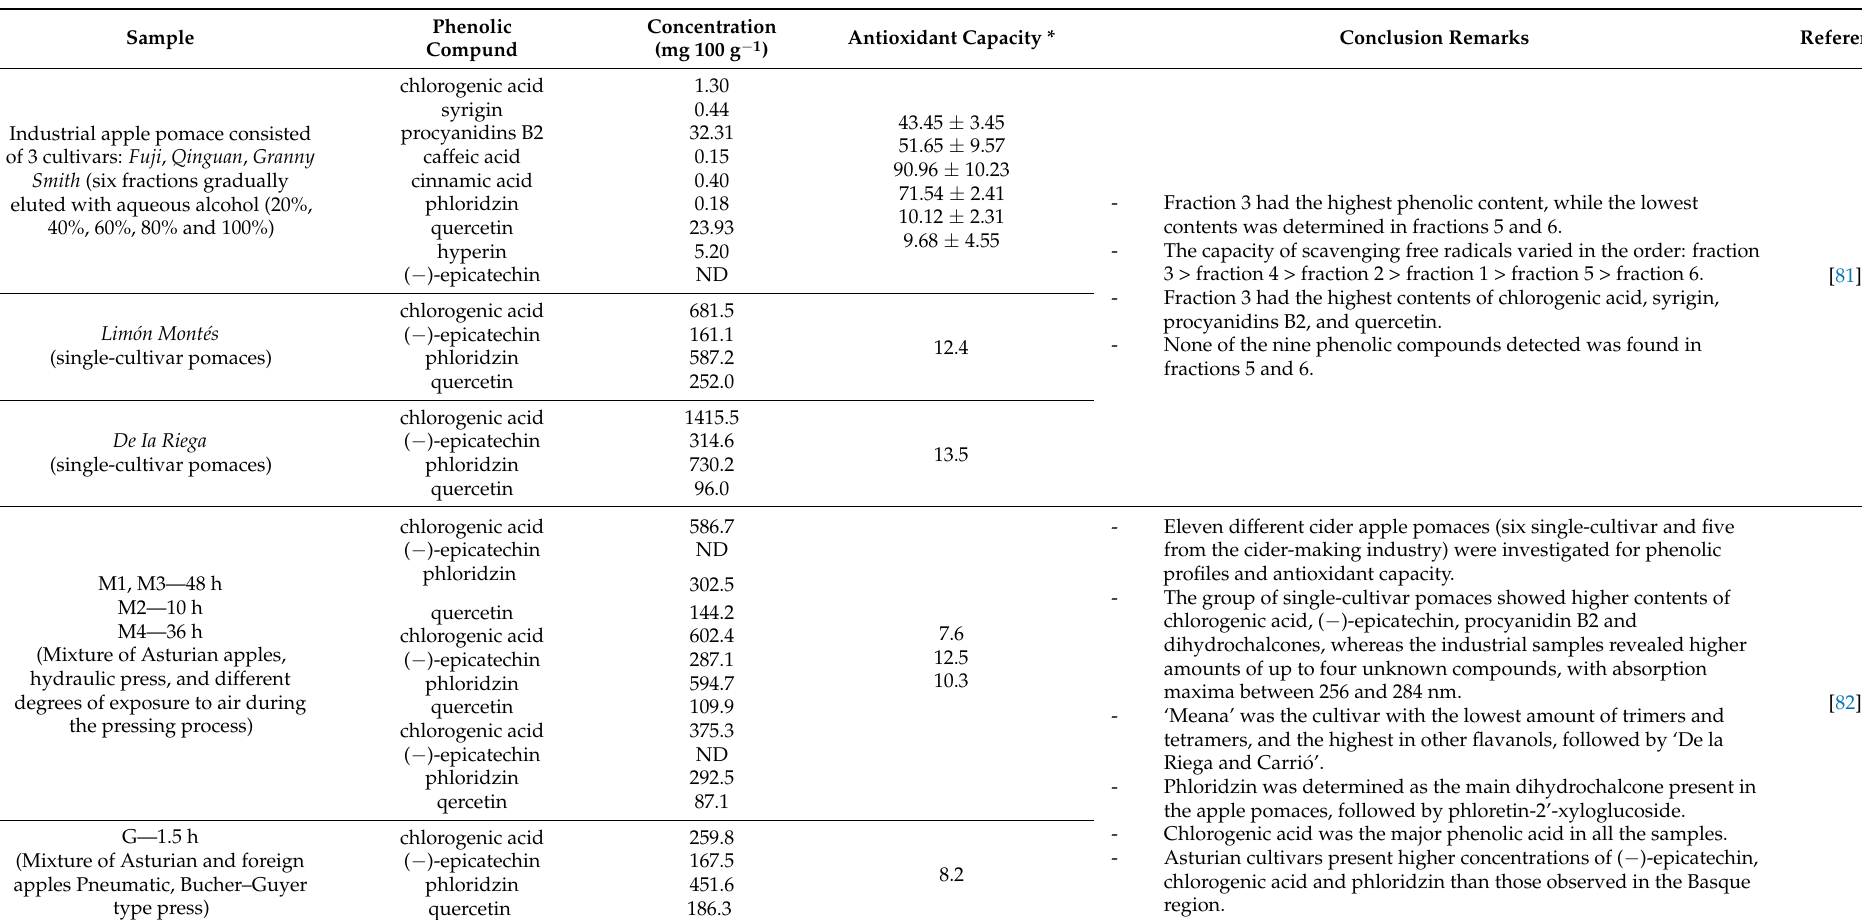
Eleven different cider apple pomaces (six single-cultivar and five from the cider-making industry) were investigated for phenolic profiles and antioxidant capacity.